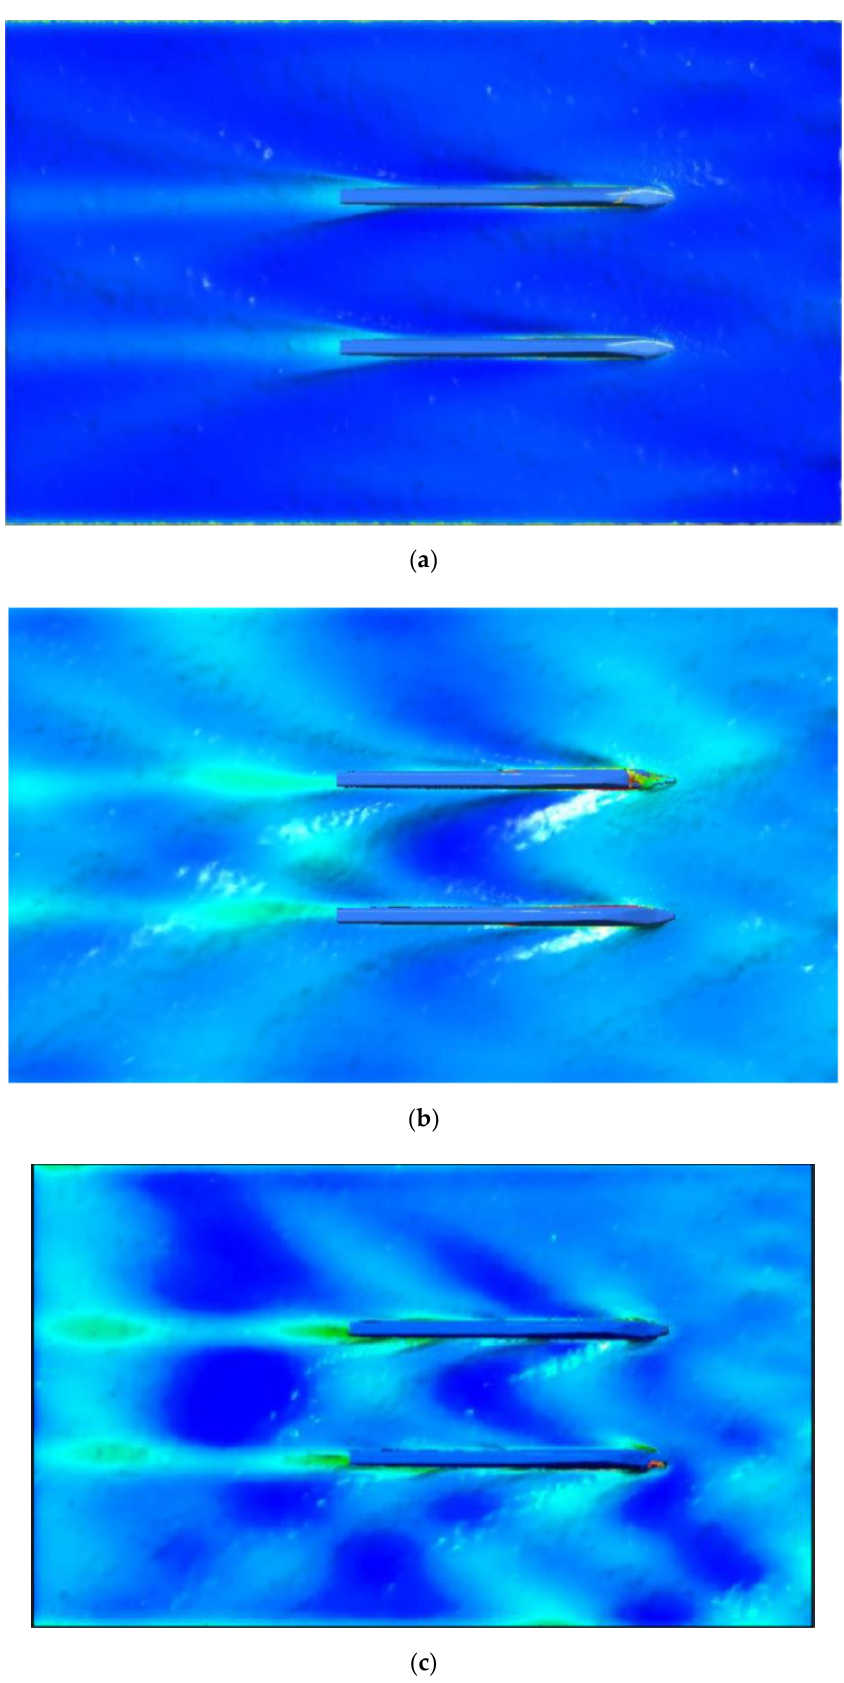
Figure 12. Wave interference at different Froude numbers: ( a ) 0.45; ( b ) 0.55; ( c ) 0.65.